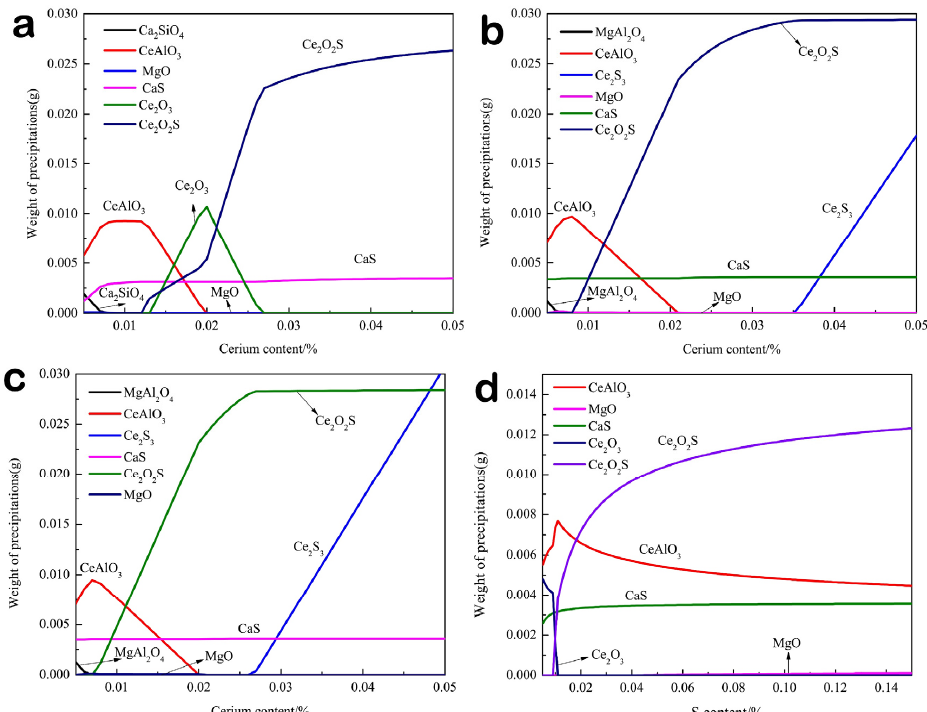
Figure 9. Thermodynamic calculation of the effect of cerium content and sulfur content on inclusion formation by FactSage. ( a ) Effect of Ce content on inclusion formation in steel containing 0.01% sulfur content ( b ) Effect of Ce content on inclusion formation in steel containing 0.06% sulfur content ( c ) Effect of Ce content on inclusion formation in steel containing 0.132% sulfur content ( d ) Effect of S content on inclusion formation in steel containing 0.013% Ce content.